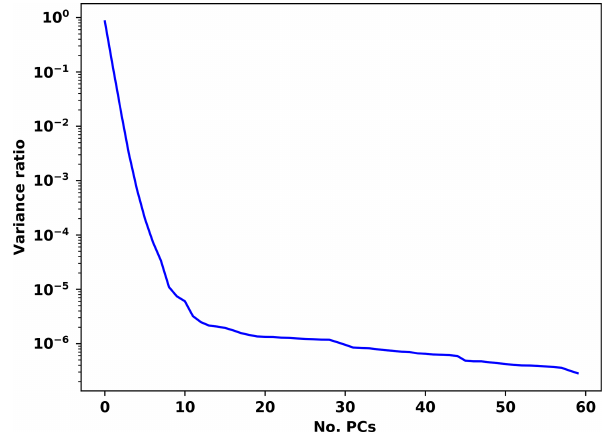
Figure 1. “Explained” variance ratio as a function of the number of principal components. The inclusion of 10 PCs already accounts for 99.994% of the spectral